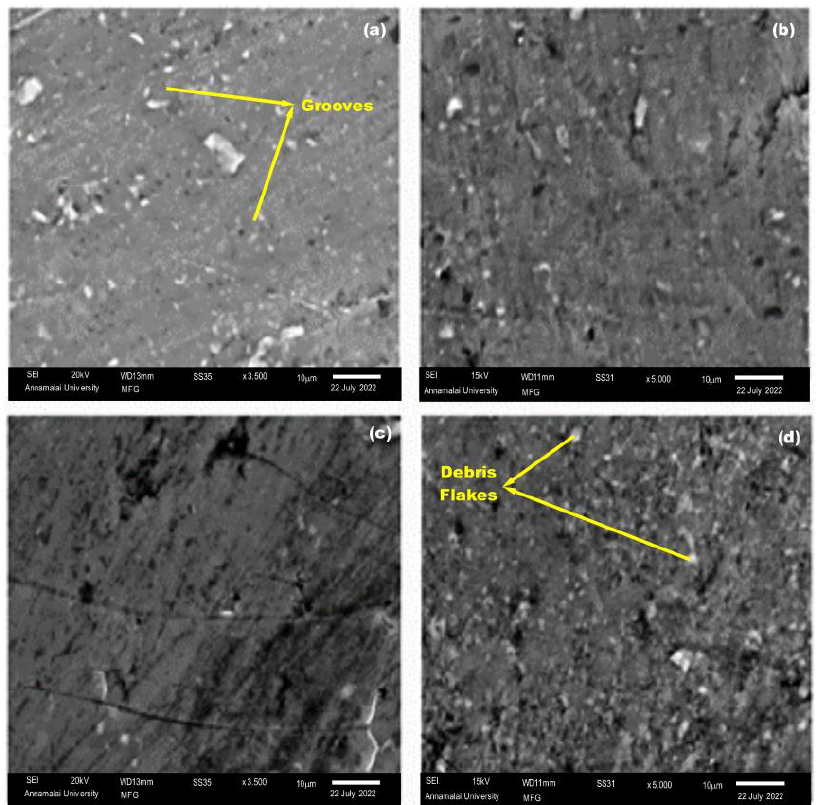
Figure 16. Micrographs showing worn-out surfaces of TiB 2 -15Si 3 N 4 -3B 4 N at: ( a ) 6 N, ( b ) 12 N, ( c ) 18 N, and ( d ) 24 N.